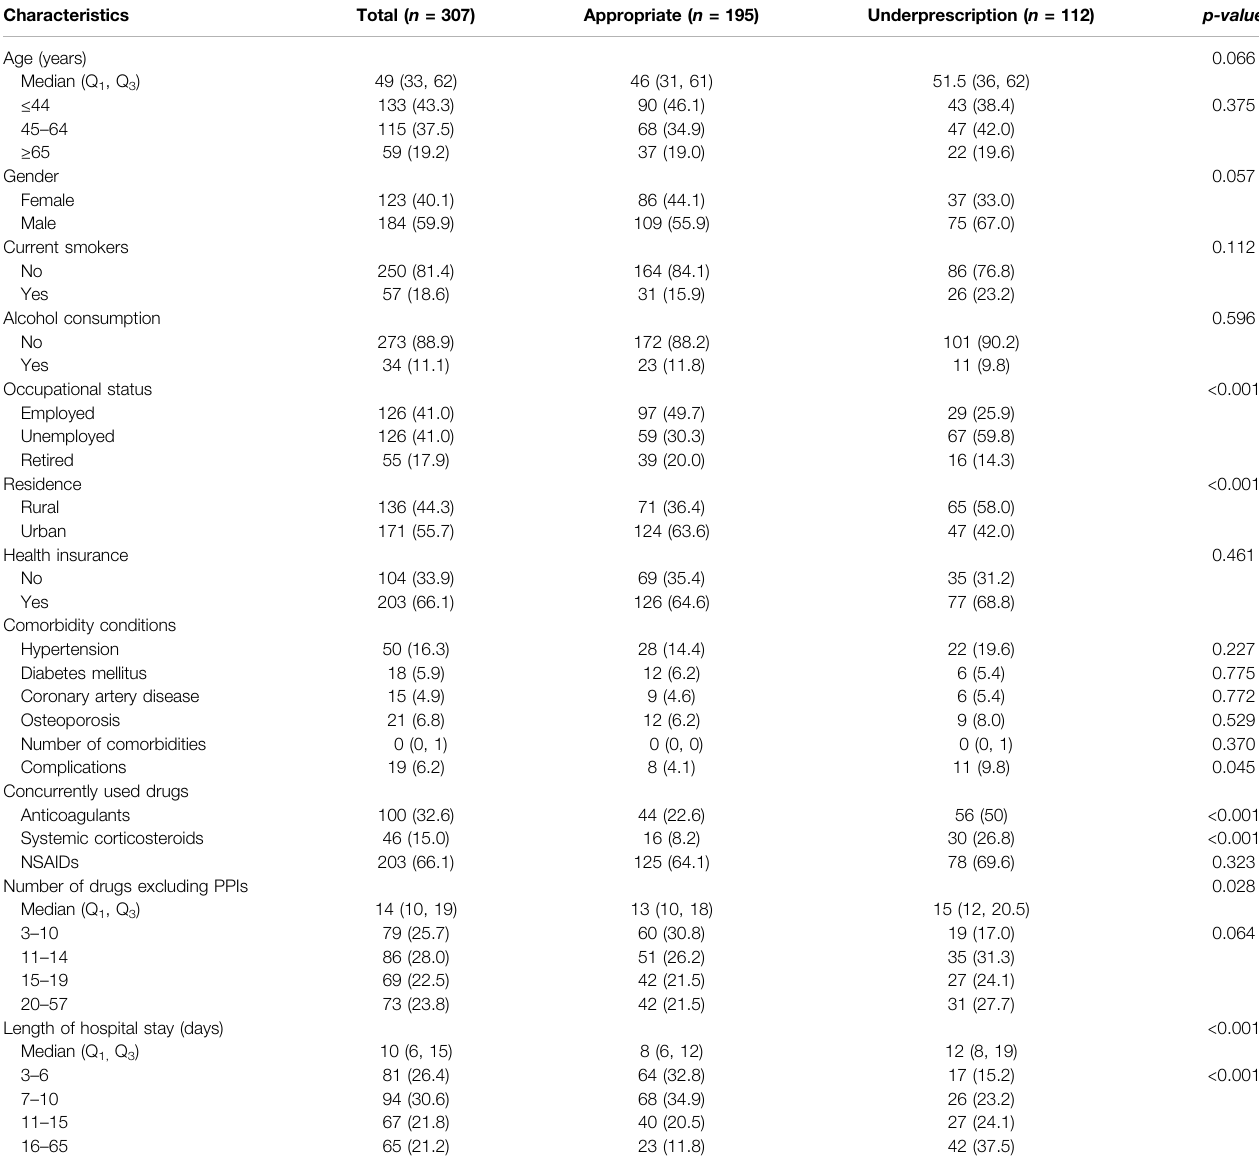
TABLE 6 | Demographic and clinical characteristics of the inpatients without ASMs prescription for SUP.